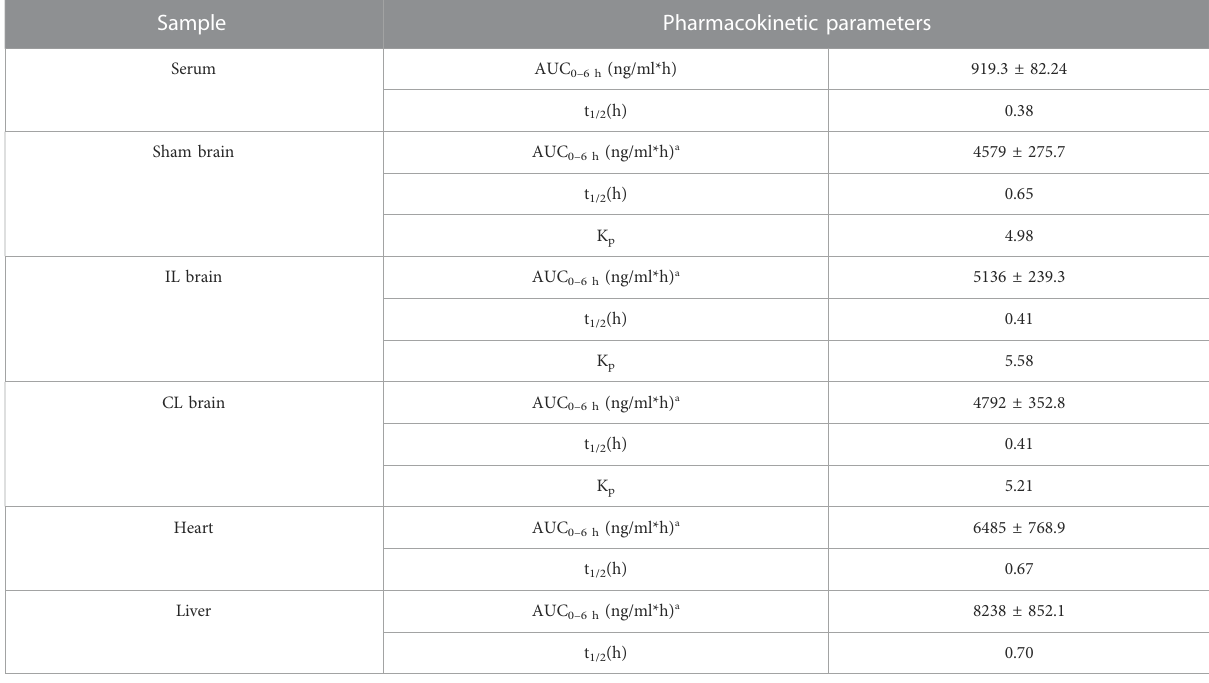
TABLE 2 PK parameters of TJ-5 in tissues of mice (mean ±